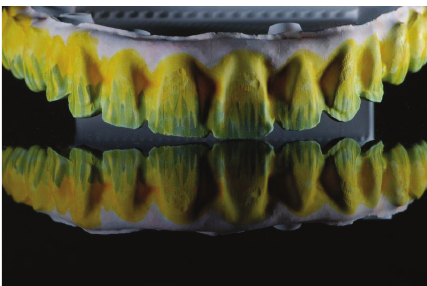
Figure 6: Maxillary monolithic prosthesis with teeth characteriza- tion.